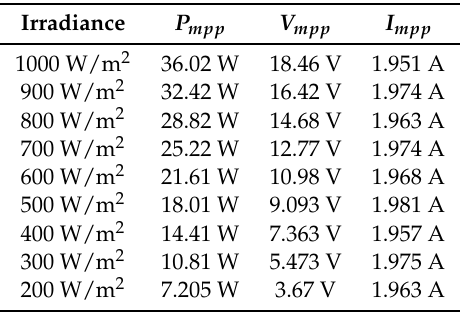
Table 1. Operating points